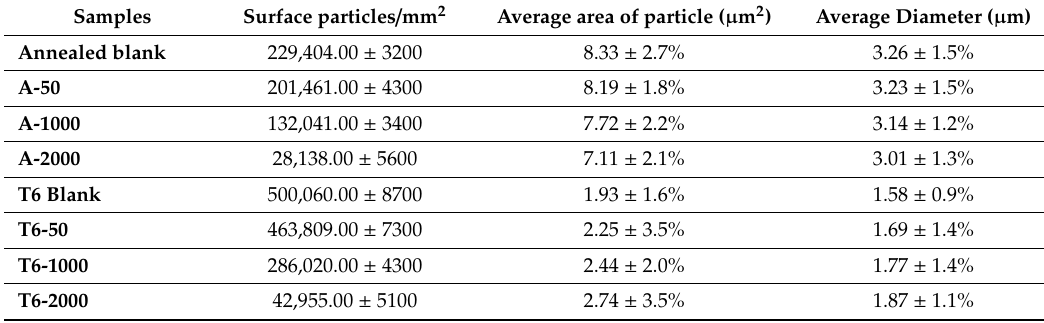
Table 5. Summary of SEM analysis for second-phase particles in successfully formed sheets.